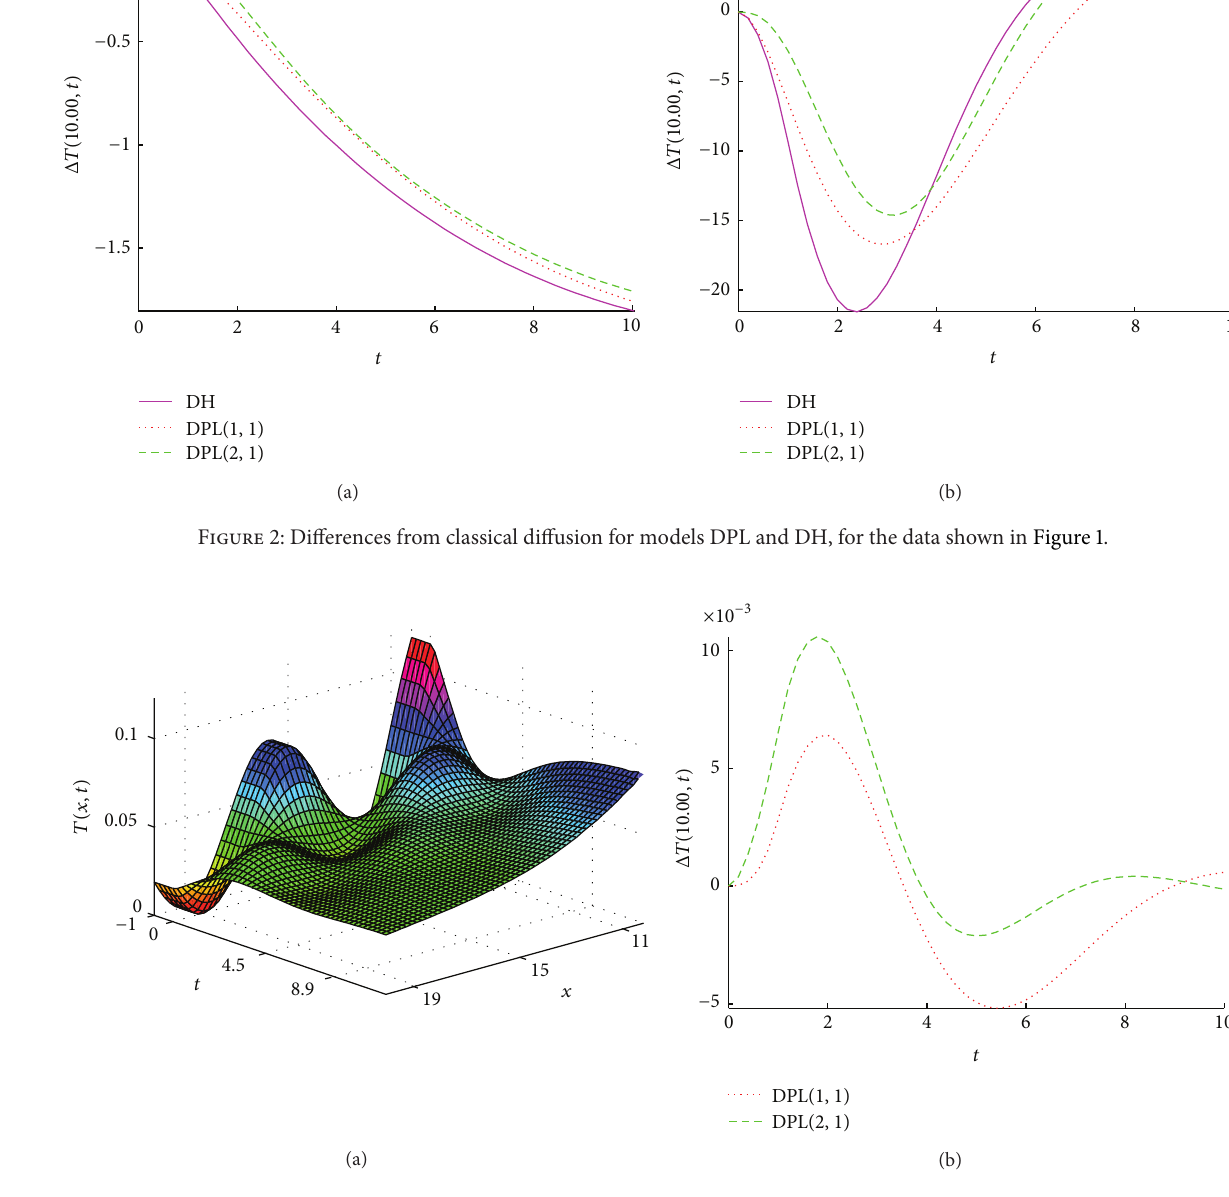
Figure 3: Temperature evolution, for (𝑥,𝑡) ∈ [10, 20]×[0,10] , for the DH model with Dirichlet boundary conditions and parameters 𝜏 𝑇 = 0 , = 1 , 𝛼 = 0.8 , and initial function 𝜑(𝑥,𝑡) = 2(1 − cos (𝑥))/(𝜋𝑥) (a), and differences from DH of DPL( 1, 1 ) and DPL( 2, 1 ) at 𝑥 = 10 𝜏 𝑞